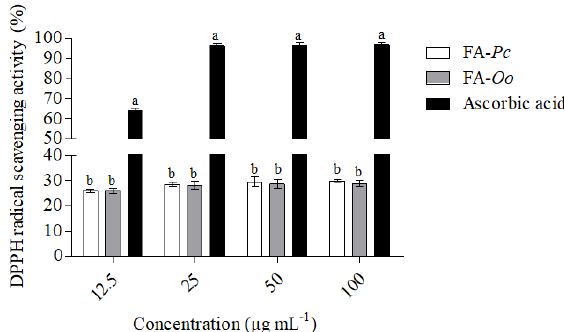
Figure 2 - DPPH radical scavenging activity of fatty acids (FA) present in the hexane extract from marine red algae Pterocladiella capillacea ( Pc ) and Osmundaria obtusiloba ( Oo